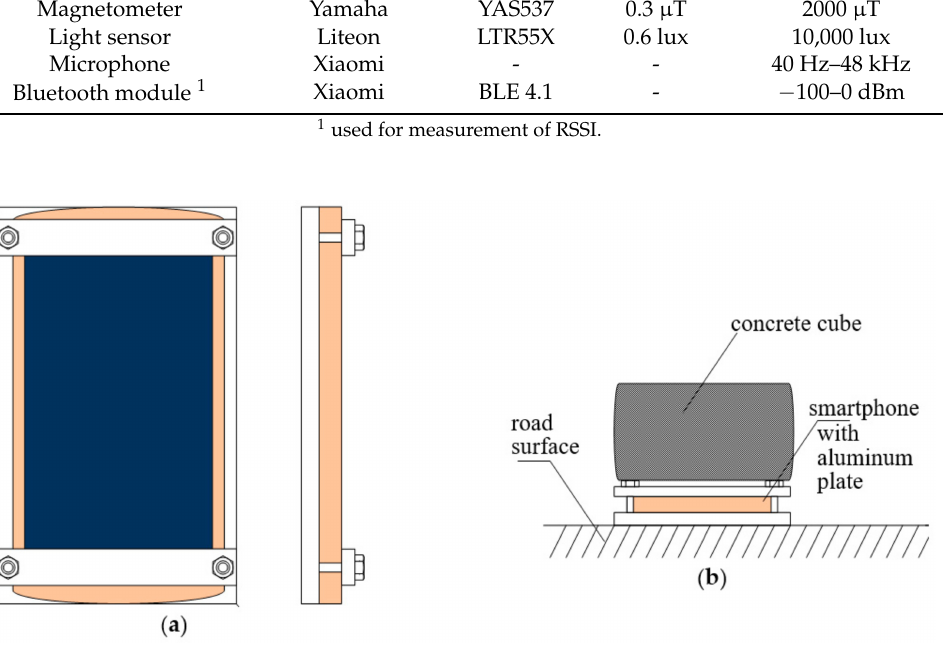
Figure 1. First model of sensor node (SN1): ( a ) smartphone attached to aluminum plate; ( b ) placement of the device during